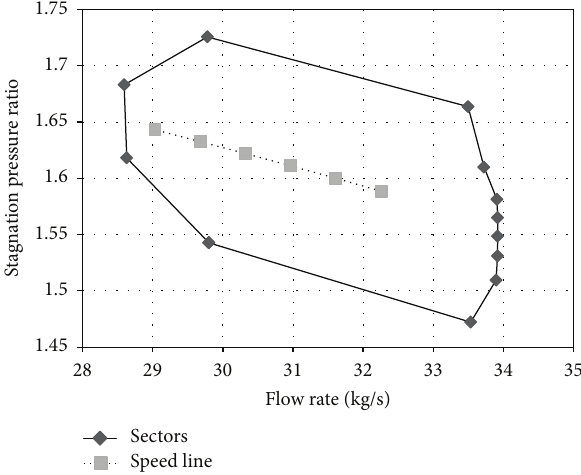
Figure 8: Total pressure ratio of clean and distorted sectors and the speed